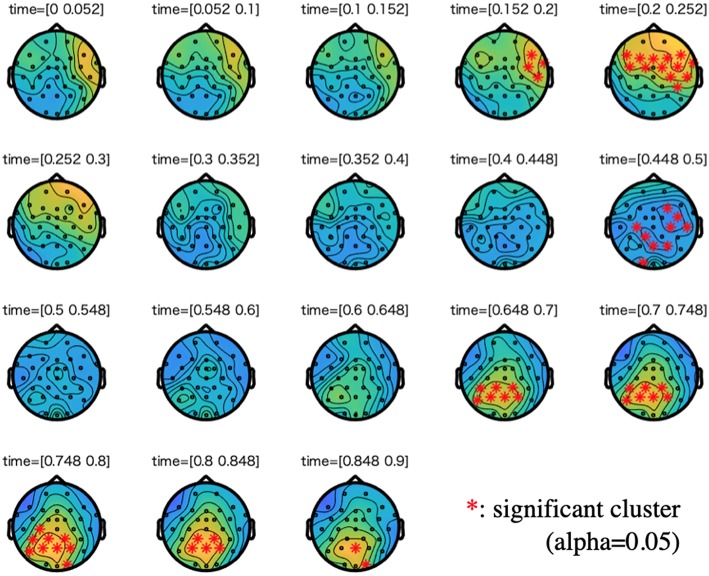
Cluster-based permutation tests on the event-related potentials (ERPs) of the semantic condition along with a difference wave between incorrect and correct conditions. We plotted 0–900 ms to the stimuli onset. For each time step of interest (time range: 0.05), we highlighted the electrodes that are members of significant clusters (cluster alpha value: 0.05). A cluster is significant if its p-value is less than the critical alpha level.